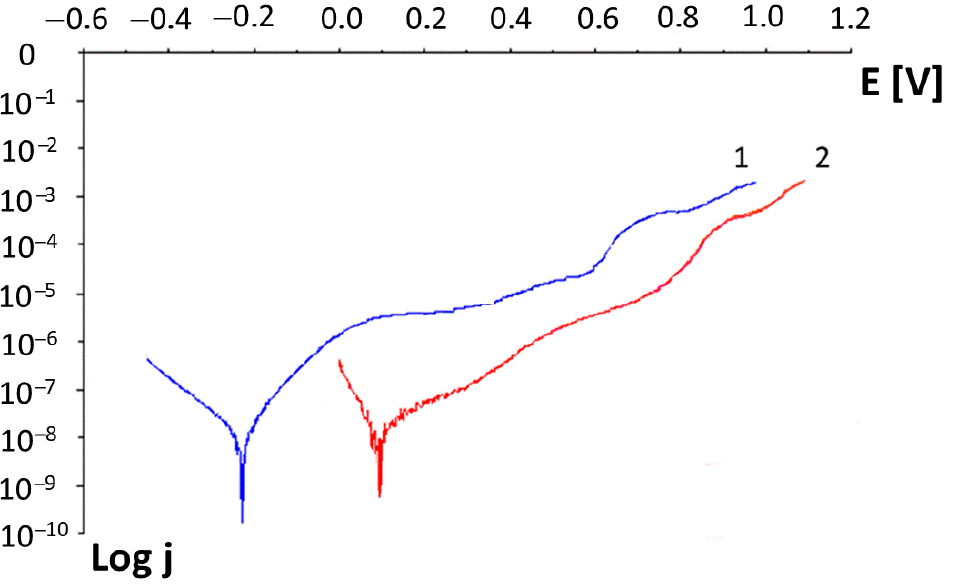
Figure 5. Exemplary current-potential characteristics; 1–Ni-Cr alloy sample with a carbon layer, 2–Ni-Cr alloy sample without a coating. Table 3. Mean values of breakthrough potentials of the examined samples Eb.